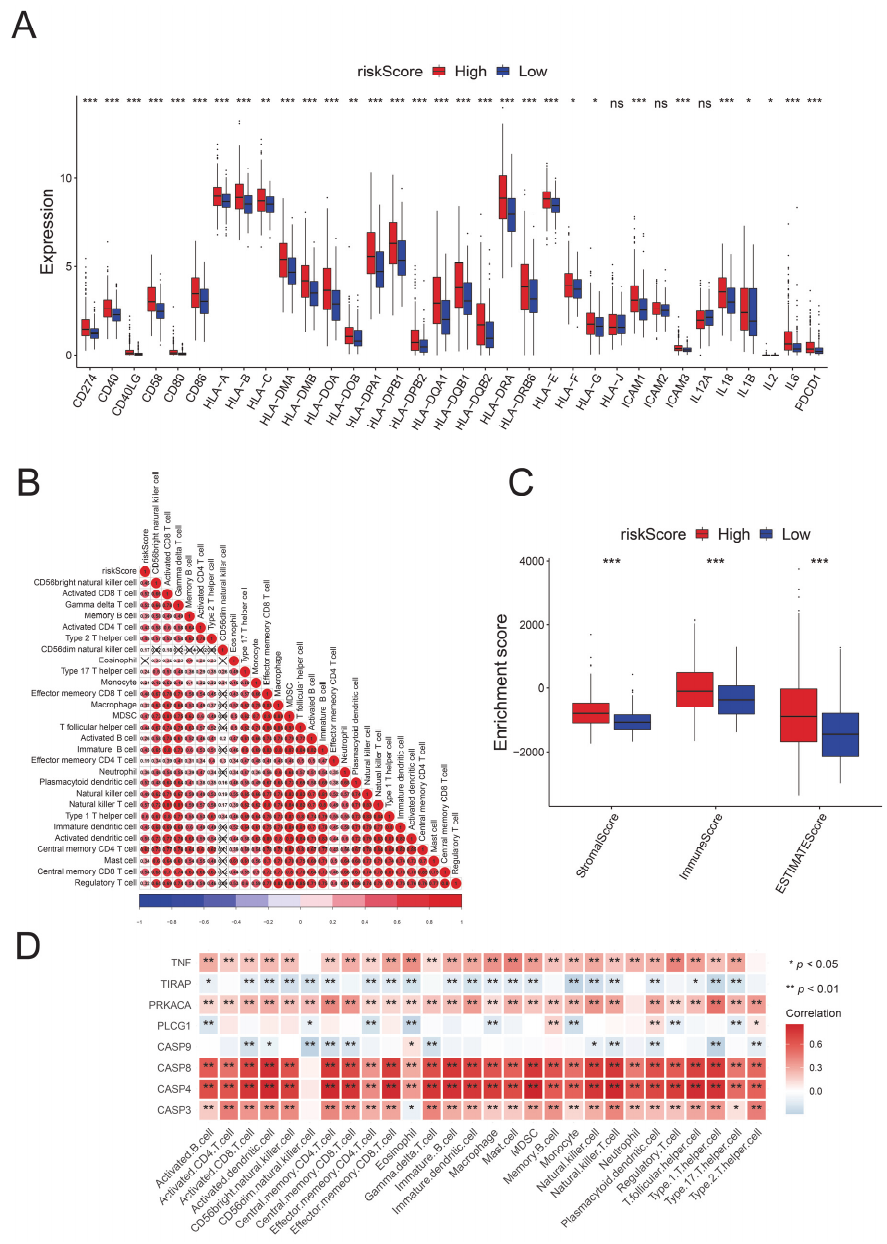
Figure 9. Characteristics of the TME in the different PyroScore risk groups. ( A ) Differences in MHC class I gene and immune checkpoint gene expression between different risk groups. ( B ) Correlation analysis of PyroScore and immune cells. ( C ) Comparison of ImmuneScore, StromalScore, and ESTIMATEscore between the two risk groups. ( D ) The relationship between immune cells and eight model genes (ns not significant; * p < 0.05; ** p < 0.01; *** p <